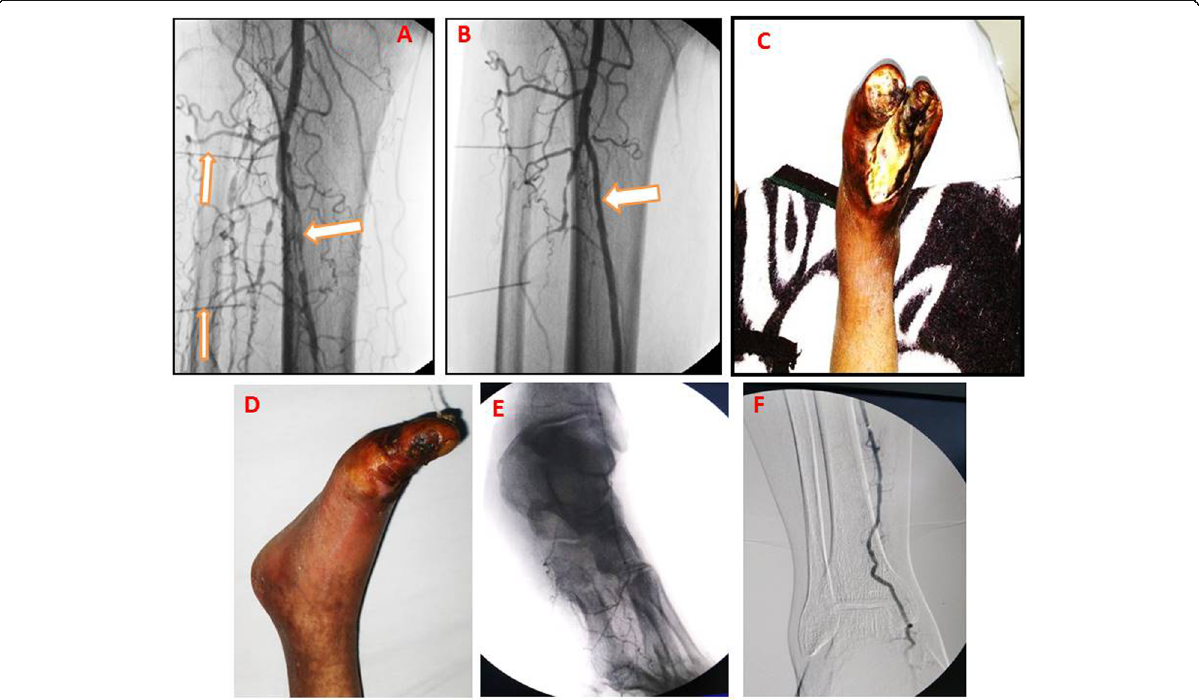
Fig. 4 A 67-year-old male patient comes with large unhealed Rt. foot ulcer at the dorsum extending to the big toe as well as second toe: a Pre- procedure below-knee arterial angiogram where the vertical arrows refer to the radio-opaque landmark and the horizontal arrow indicates the markedly stenosed segment of PTA. b Post-procedure angiogram where the horizontal arrow refers to the recanalized segment of the PTA. c The foot before intervention. d The foot few months after revascularization. e , f Post-procedure foot angiogram with average foot